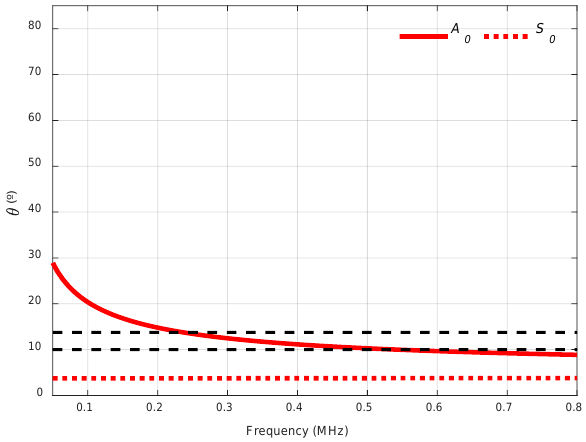
Figure 14. Incidence angle dispersion curves for a stainless-steel plate and air as the coupling medium ( c = 343 m / s). The chosen angles (10 ◦ , 13.75 ◦ ) are represented by black discontinuous curves.